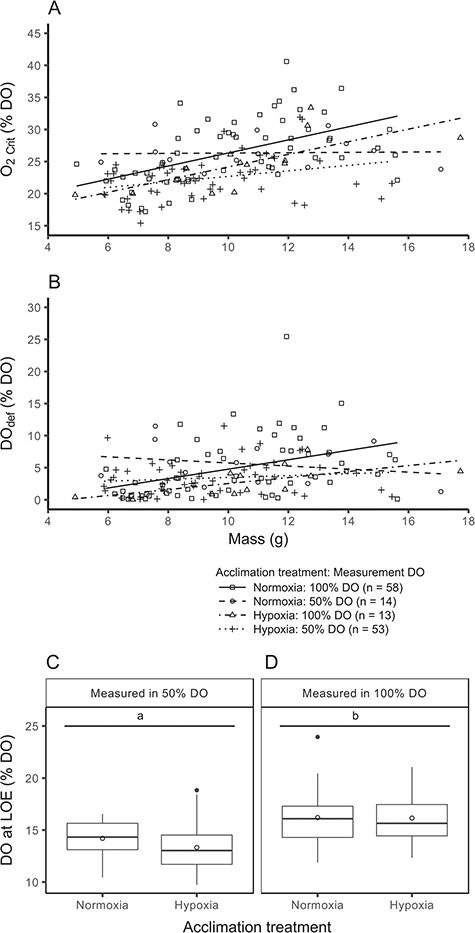
Relationships between mass and O2crit (A) or DOdef (B), along with boxplots of DO at LOE (C, D) in Atlantic salmon (Salmo salar) acclimated in hypoxia or normoxia and then measured in 50 or 100% DO. Because there was no difference between incubation treatment groups, they were pooled (all incubation treatment groups are displayed in Fig. S3). For scatterplots (A, B), data points represent individuals and lines are linear relationships for each treatment group combination. For boxplots (C, D), the solid central line is the median, the box denotes the 25th and 75th percentiles, whiskers extend to the highest or lowest value within 1.5*inter-quartile range and filled circles are outliers beyond that range. Mean values are represented by open circles. Different lowercase letters indicate significant differences between groups (C, D; Tukey, P < 0.05).